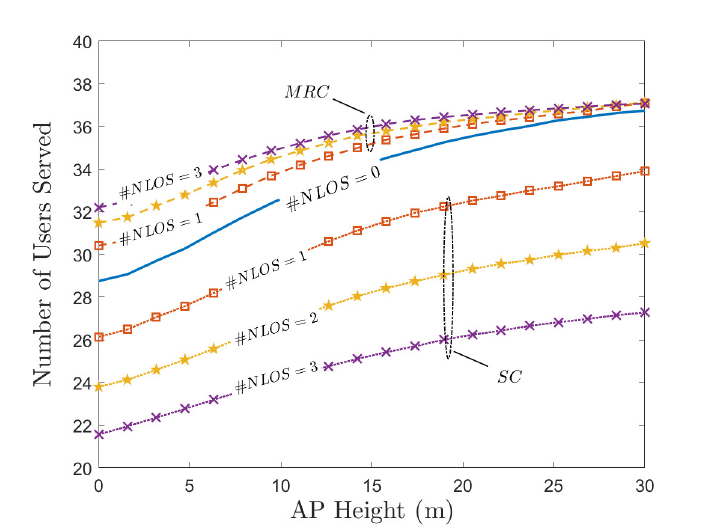
Figure 16. Average users served M s within square area 200m × 200 m vs. UCA height h , solid lines is the no NLOS ( L = 1), while dashed lines with marker are with NLOS for L = 2,3,4, with MRC and SC receivers for N c = 500, λ = 10 − 3 m − 2 ; 2 b = 2.6, SIR threshold [ T ] dB = 0, R max = 400m, the normalized amplitude | β (cid:96) | = 1 for every path (cid:96)